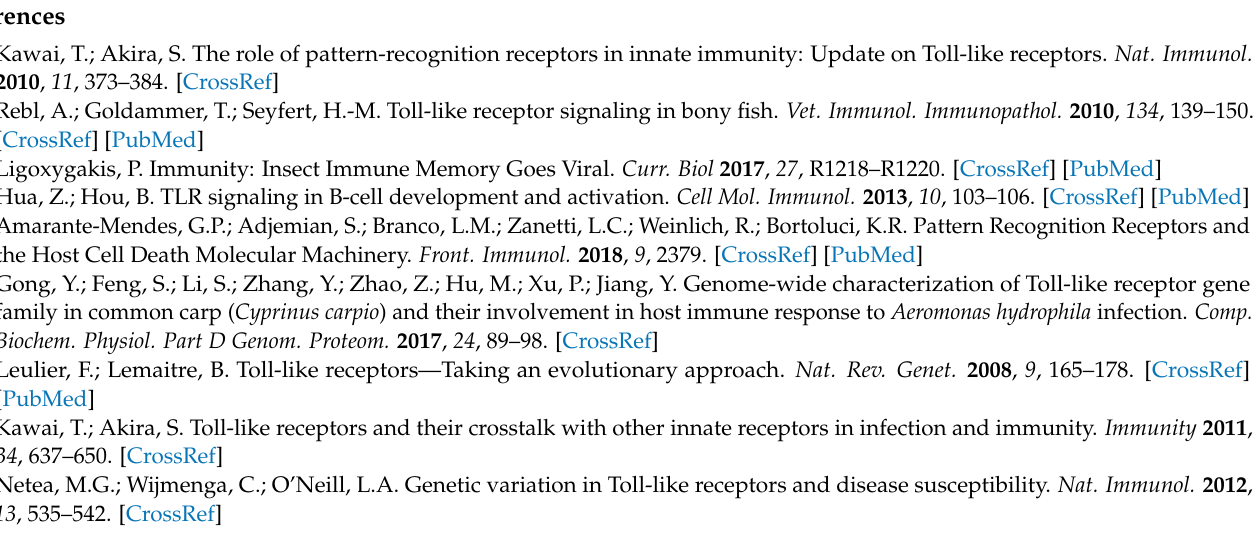
Table S2: Primer sequences, Table S3: First chain cDNA synthesis volume, Table S4: Real-time qPCR reaction